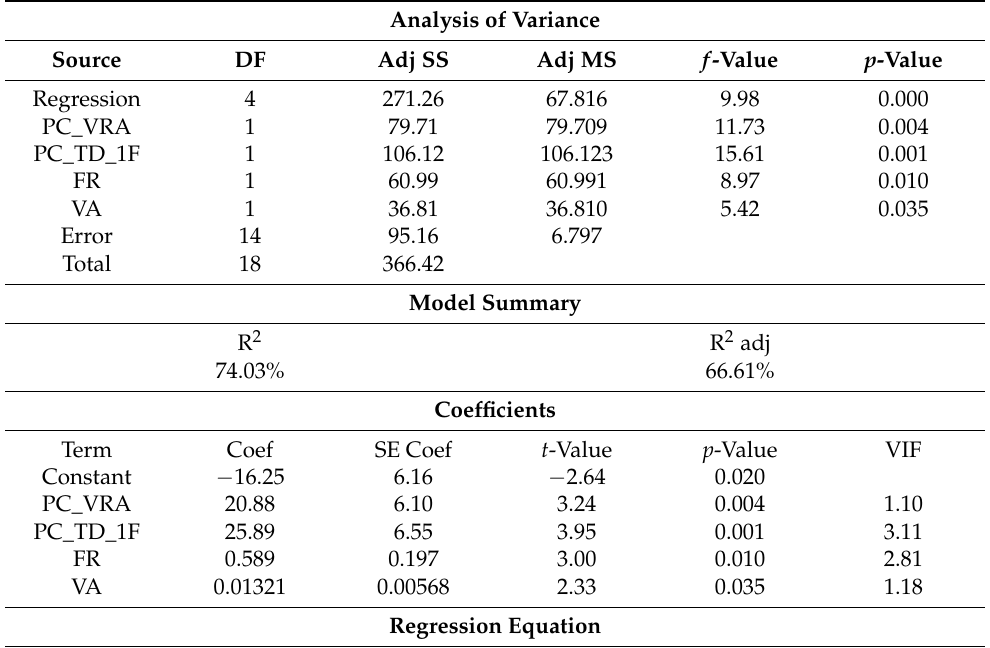
Table 5. Regression analysis for the frequency of voltage